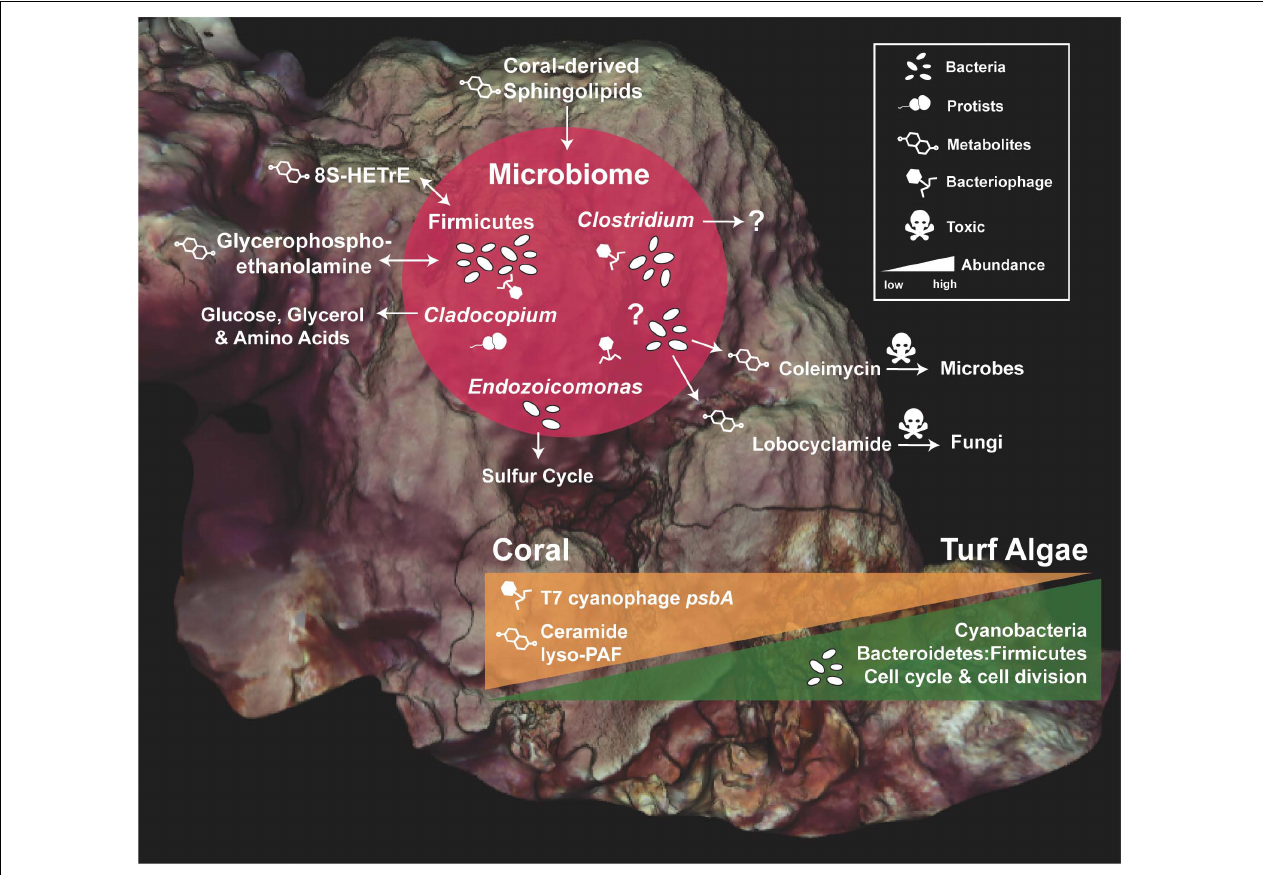
FIGURE 10 | Summary of the Orbicella faveolata holobiont and its main competitor, turf algae. Core microbial members of O. faveolata are shown along with their potential functions and interactions with the coral host (red circle). Question marks represent functions that are unknown. The change in abundance of specific bacterial groups, bacterial and phage functions, and metabolites across coral and turf algae competitors are illustrated by orange and green triangles.